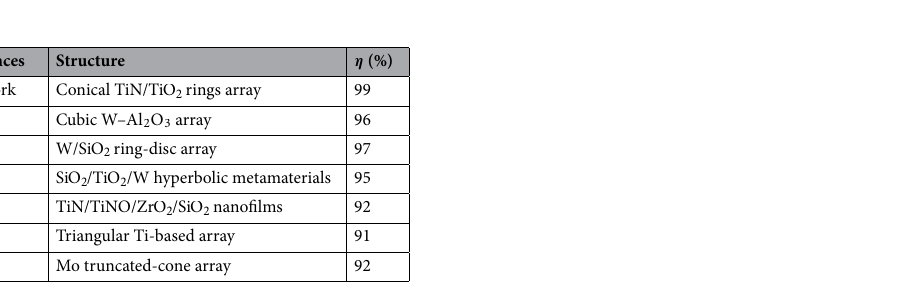
Table 3. Comparison of the absorption efficiency η of our proposed solar superabsorber with some reported relevant